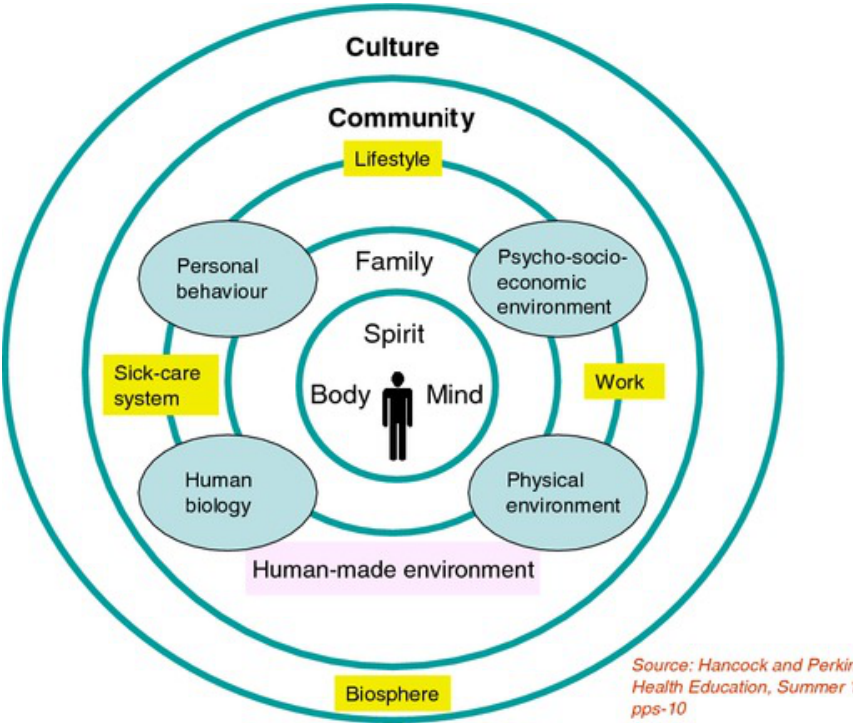
Figure 1. The Mandala of Health